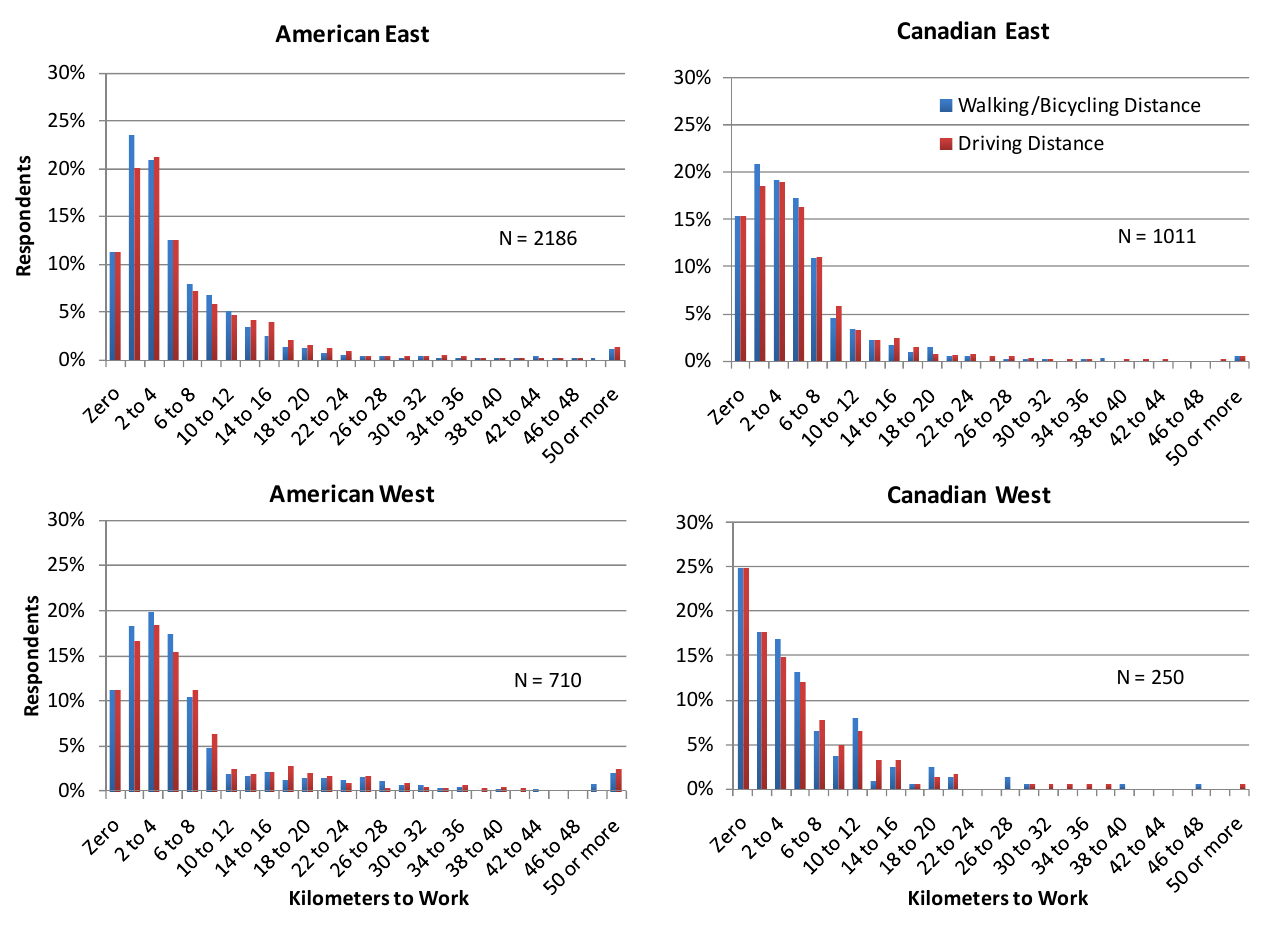
Figure 1. Distribution of Commute Distance of Carsharing Members by